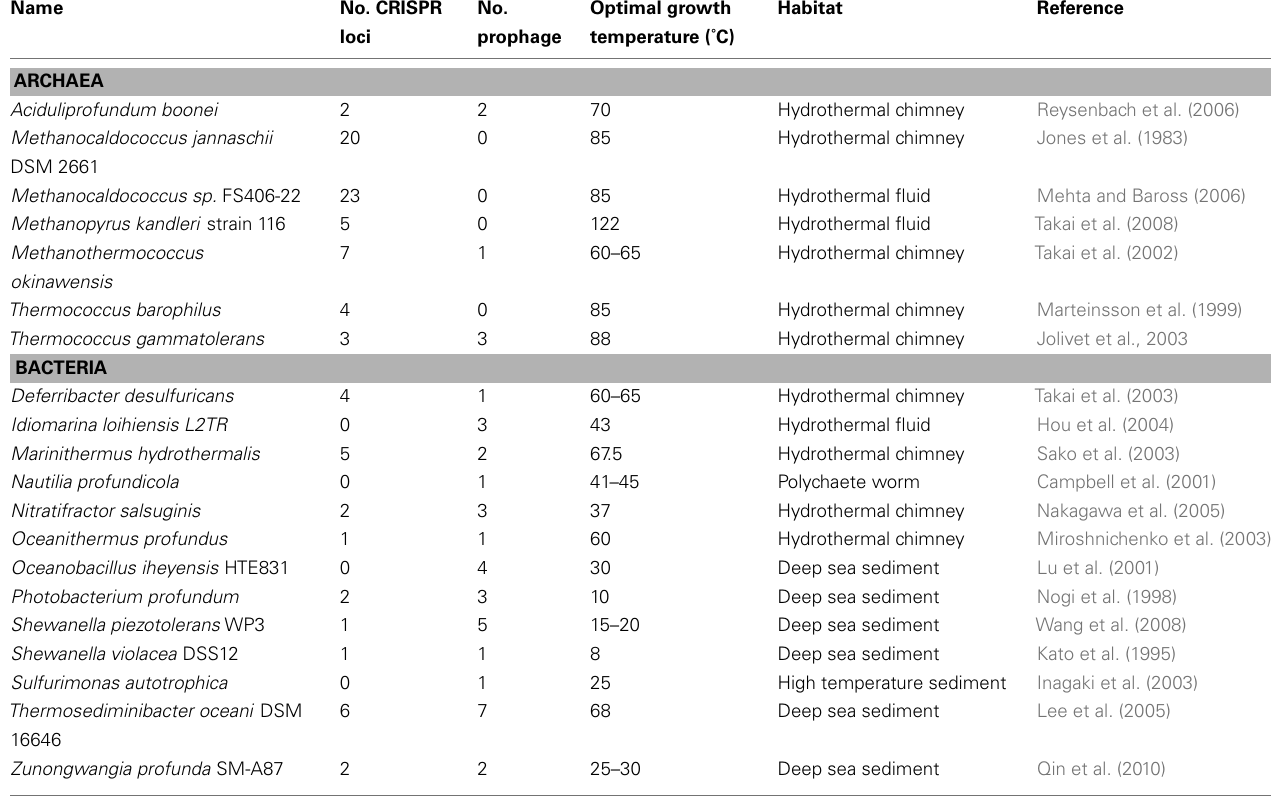
Table 2 | Habitat, thermal regime, number of CRISPR loci, and number of prophage for archaea and bacteria isolated from the deep-water column, marine sediments, or hydrothermal systems whose genomes have been